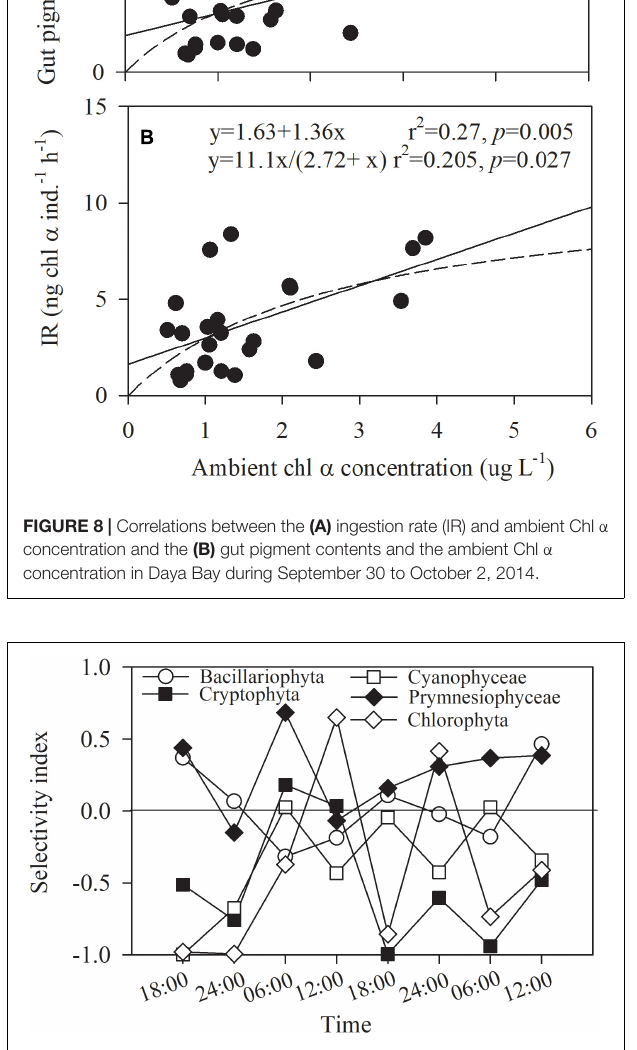
FIGURE 9 | Selectivity index of copepods for phytoplankton groups in entire water column of Daya Bay during September 30 to October 2, 2014.